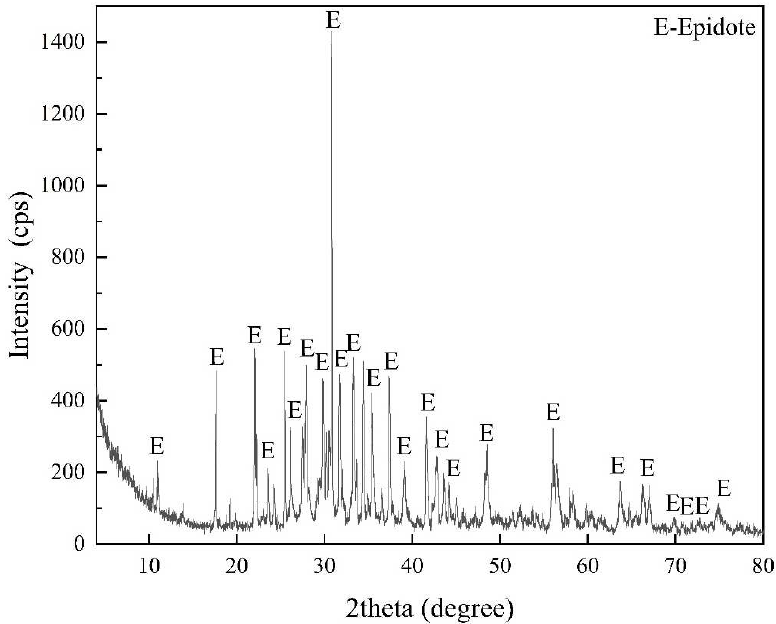
Figure 2. X-ray diffraction (XRD) spectra of epidote.